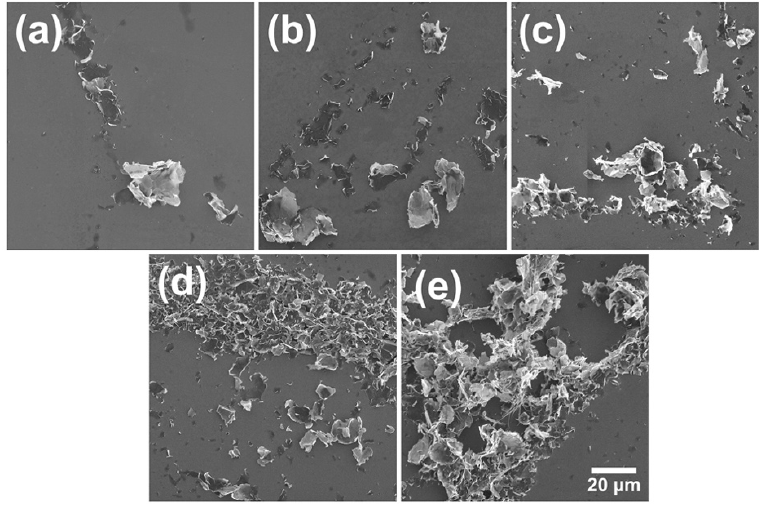
Figure 8. ( a ) Non-sonicated GNP; GNP processed by ultrasonic probe at 75% amplitude for 15, 30, 45 and 60 min (( b – e )